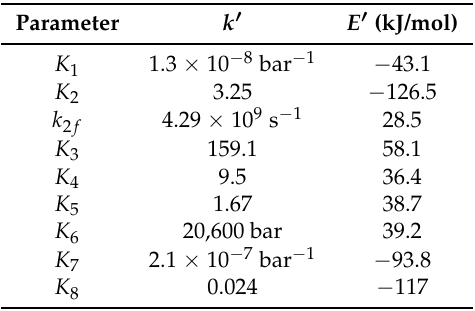
Table 1. Equilibrium and rate constants based on Arrhenius equation ( k (cid:48) exp ( − E (cid:48) / RT ) )